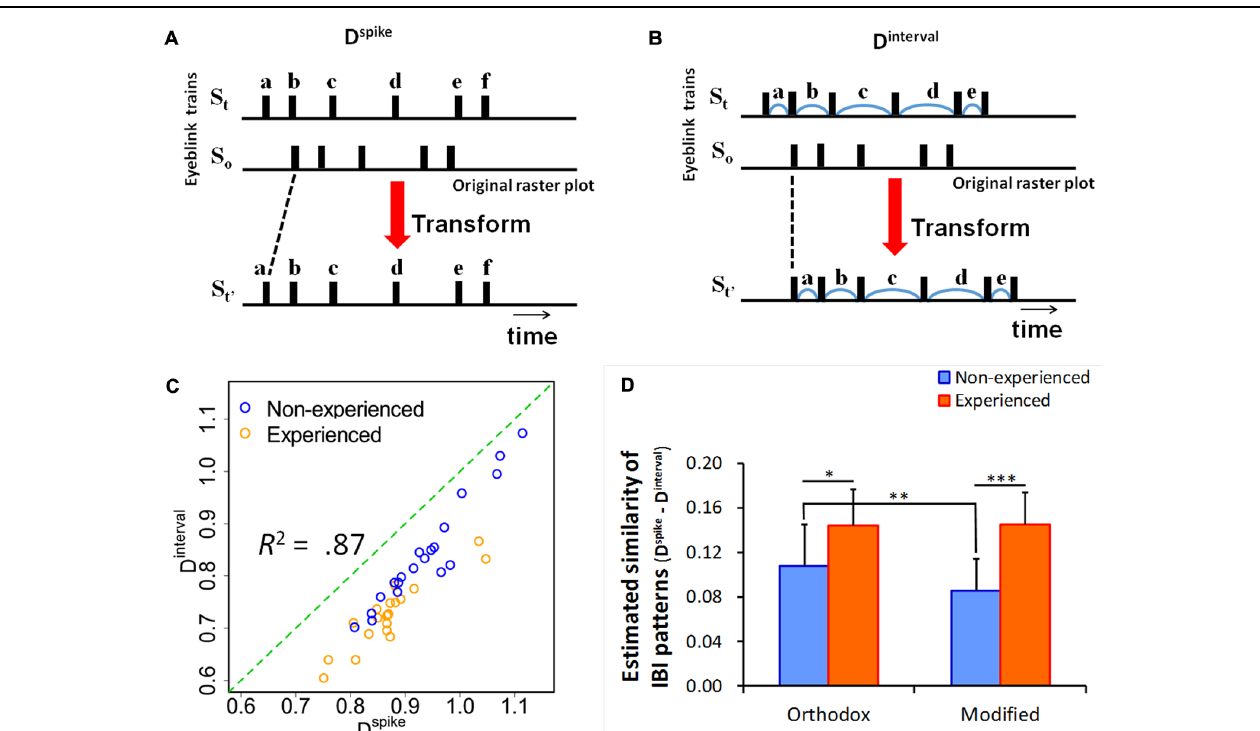
FIGURE 1 | Schematic illustration of the methods to evaluate costs to transform a train to another train and estimated similarity of inter-blink interval (IBI) patterns. (A) The distance between the two spike trains, S t and S o , is equal to seeking a path of the minimum cost, which transforms S o – S t , with spike times (a, b, c, d, e, f) equal to S t . (B) The distance between S t and S o is equal to seeking a path of the minimum